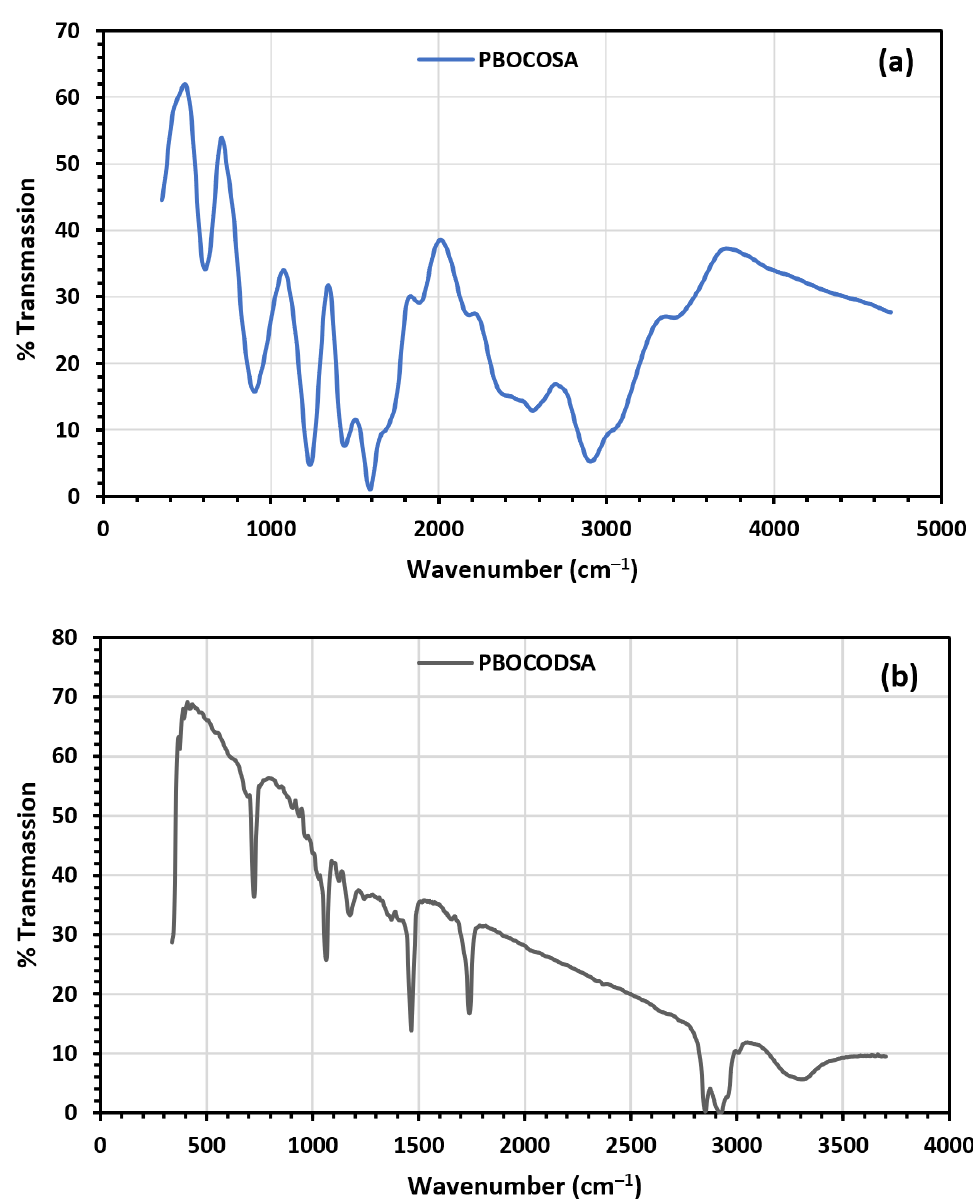
Figure 1. IR Spectrum of ( a ) PBOCOSA and its amided copolymer ( b ) PBOCODSA.